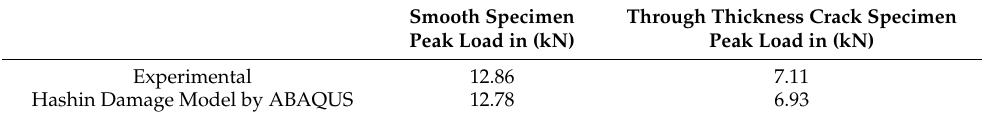
Table 5. The comparison between the experimental and numerical results of peak load. Figure 12. Load-Displacement diagram for ASTM E1922 and ASTM D3039 specimens.